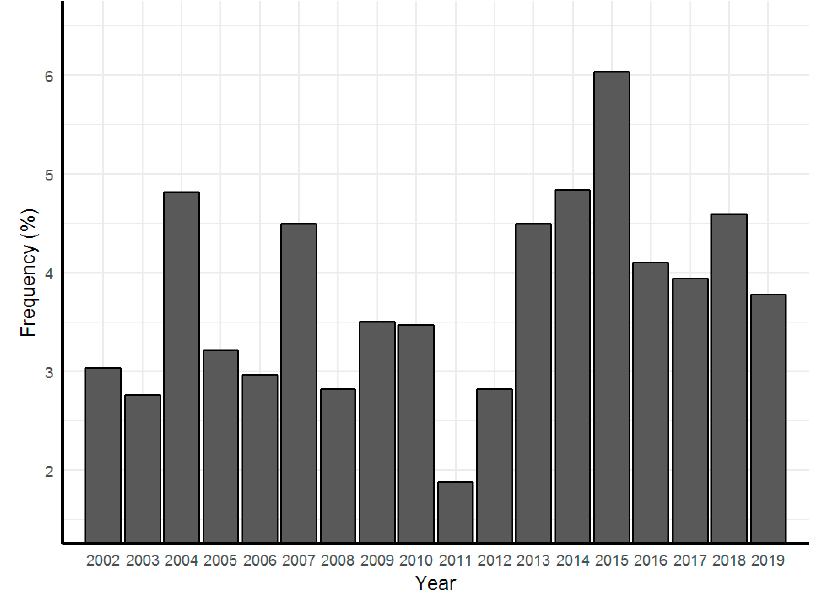
Figure 7. Annual distribution of the average annual frequency of hourly precipitation.